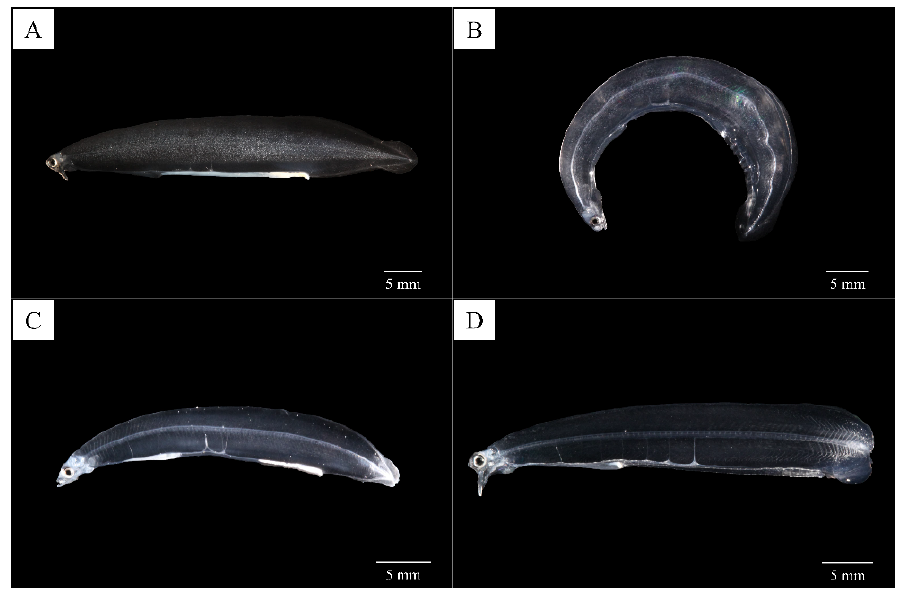
Figure 1. Abnormality of the Anguilla japonica in the leptocephalus stage in culture. ( A ) Posterior bent lower jaw. ( B ) Dorsal curvature of the notochord column. ( C ) Decayed tail fin. ( D ) Vertebrae compression and fusion of the tail region.